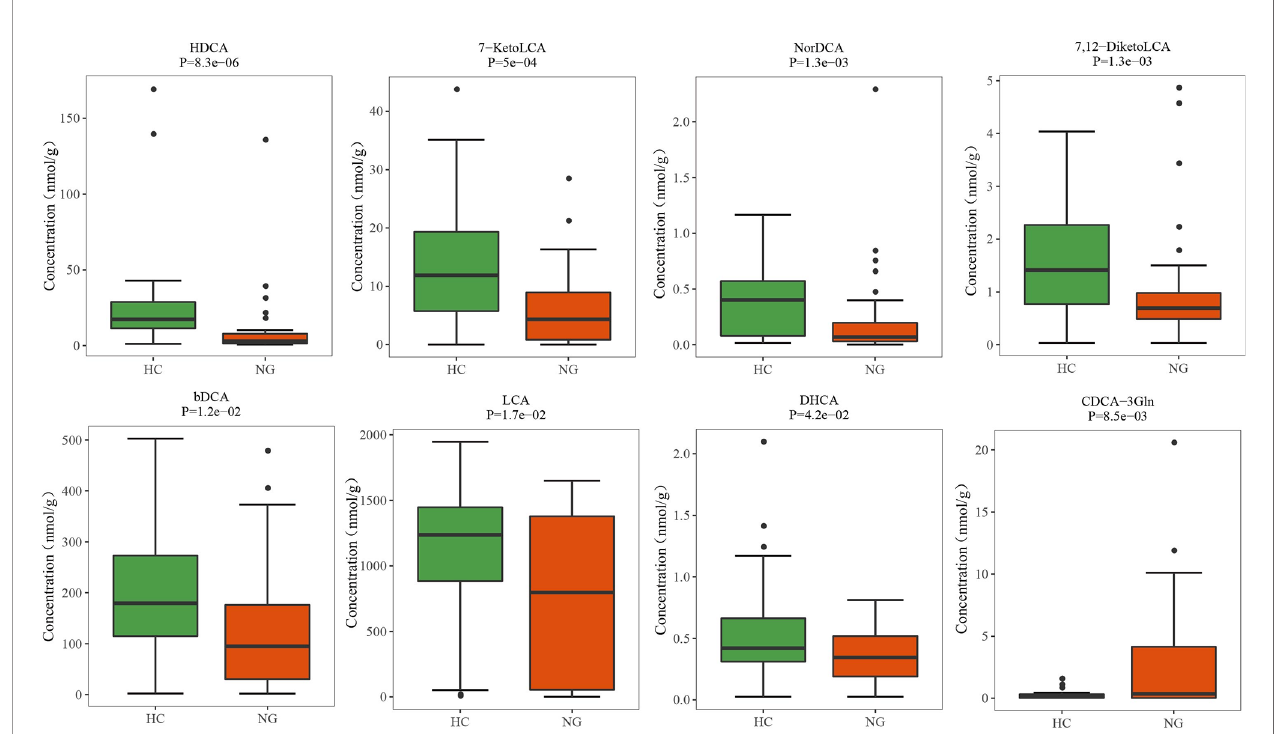
FIGURE 5 | Altered bile acid pro fi les in the fecal samples of pediatric NAFLD patients. The quantitative concentrations of primary and secondary bile acids in the cohort of children with NAFLD (NG) and the healthy controls (HC) were determined by ultra-performance liquid chromatography coupled to tandem mass spectrometry (UPLC-MS/MS). Signi fi cant differences were measured by the Wilcoxon test. HDCA, a -hyodeoxycholic acid; 7-KetoLCA, 7-ketolithocholic acid; NorDCA, 23-nordeoxycholic acid; 7,12-DiketoLCA, 7,12-diketolithocholic acid; bDCA, 3-epideoxycholic acid; LCA, lithocholic acid; DHCA, dehydrocholic acid; CDCA-3Gln, chenodeoxycholic acid, 3- b